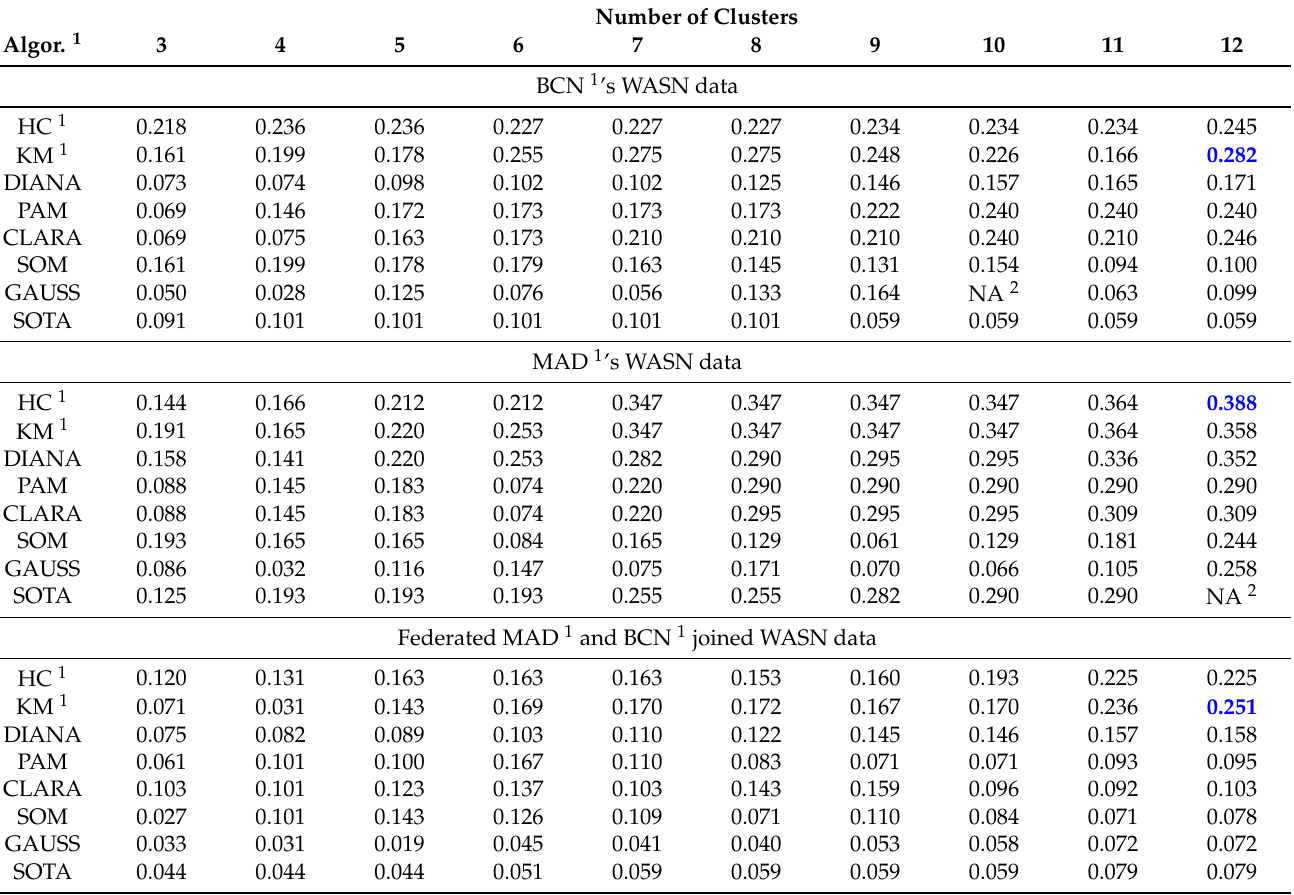
Table 4. Evaluation and comparison of clustering techniques over WASN data based on the Dunn